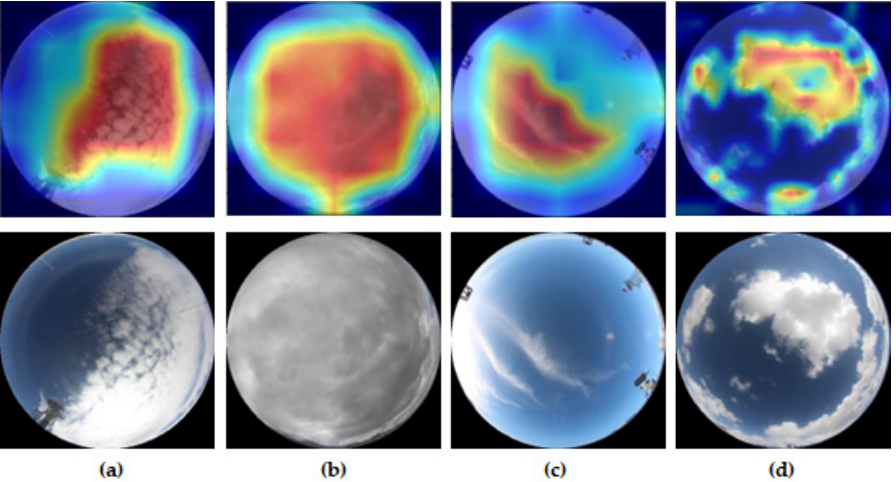
Figure 13. Grad-CAM visualization results in the ASGC dataset. Each input image is shown on the second line, and attention maps are shown on the first line: ( a ) Ac; ( b ) Cb; ( c ) Ci; ( d )